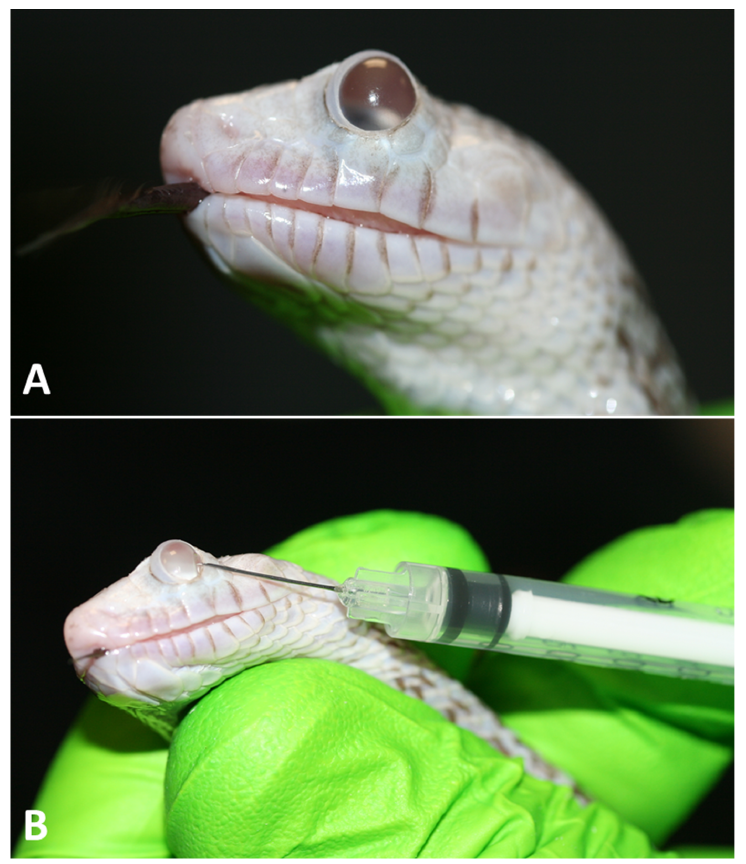
Figure 27. ( A ) Pseudobuphthalmos in a gopher snake ( Pituophis catenifer ). ( B ) Drainage of the subspectacular space via punction through the spectacle.